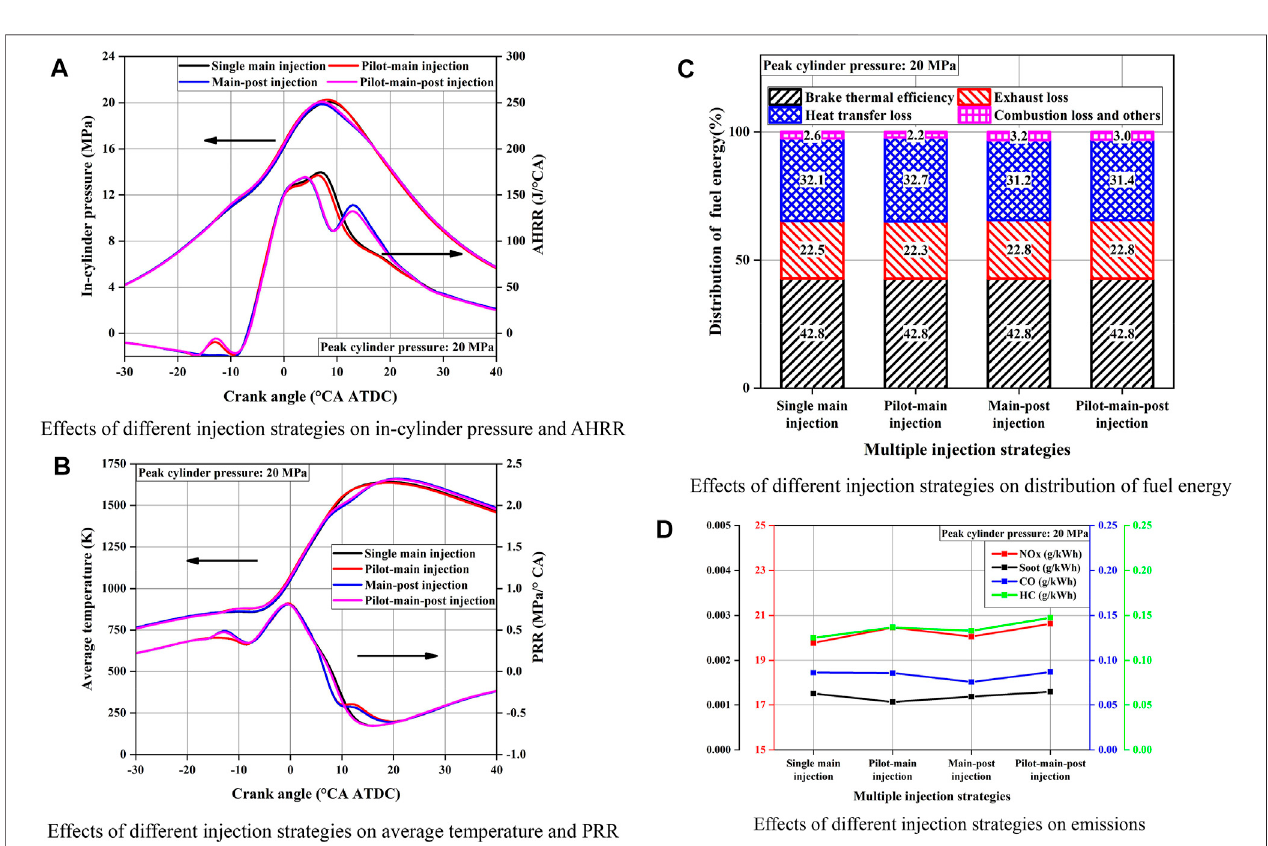
FIGURE 13 | Effects of different injection strategies on performance at 20 MPa PCP. (A) Effects of different injection strategies on in-cylinder pressure and AHRR, (B) EffectsofdifferentinjectionstrategiesonaveragetemperatureandPRR, (C) Effectsofdifferentinjectionstrategiesondistributionoffuelenergy, (D) Effectsofdifferent injection strategies on emissions.